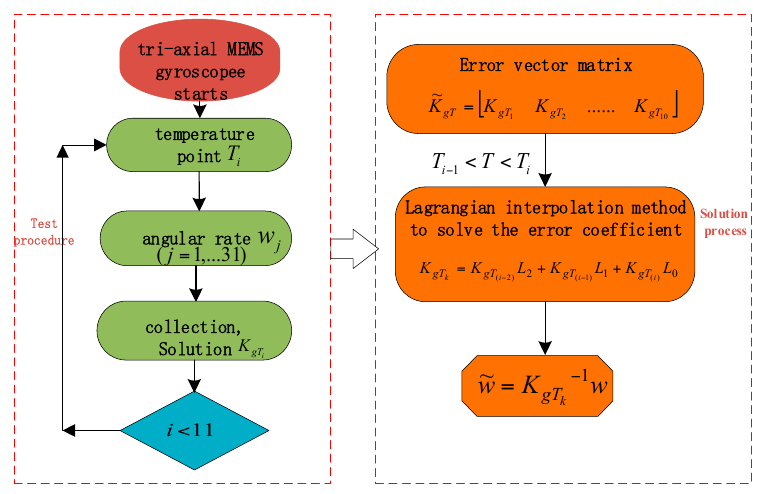
Figure 2. Error compensation flow chart.